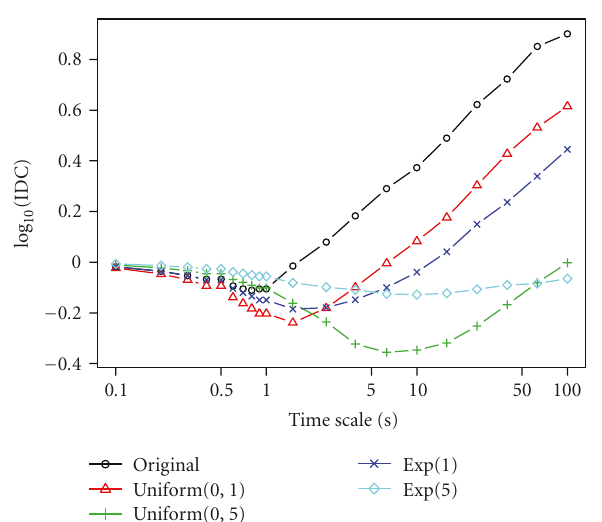
Figure 21: The IDC of the original packet arrival process in Kore1 and those of the versions under sophisticated